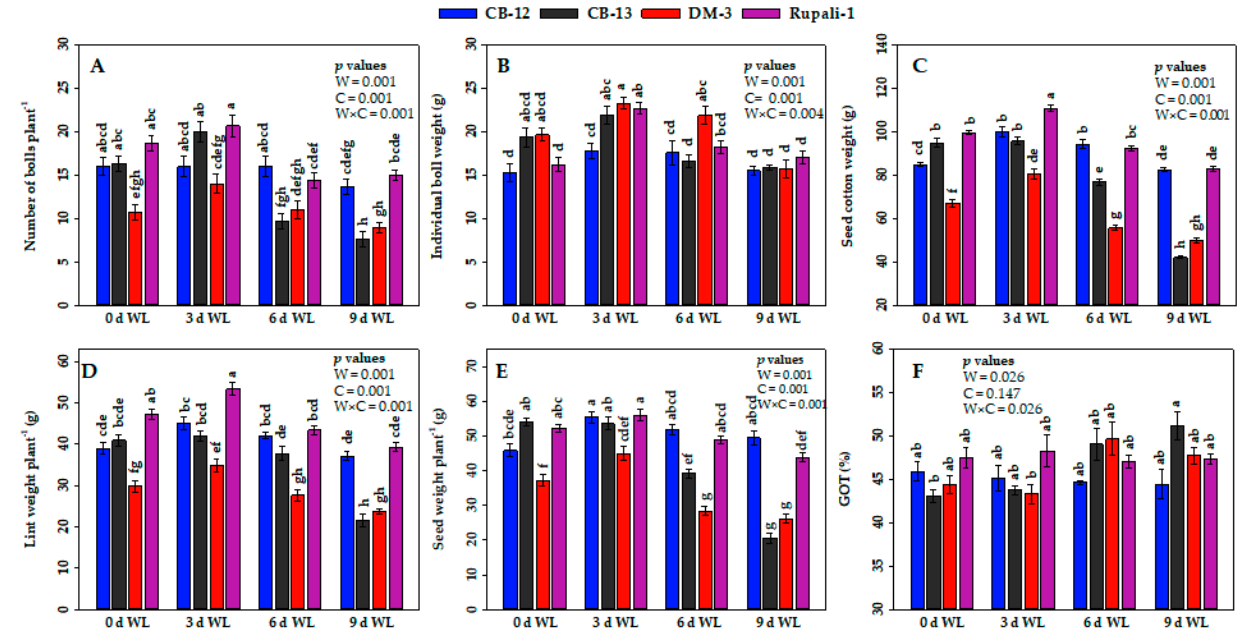
Figure 4. Effect of waterlogging (WL) on ( A ) number of bolls plant − 1 ; ( B ) individual boll weight; ( C ) seed cotton weight; ( D ) lint weight plant − 1 ; ( E ) seed weight plant − 1 ; and ( F ) ginning out turn (GOT). Values are means ± standard error. Bars connected with different letters have significant differences. p values are presented at the top right corner of the graphs. W = WL duration, C = cotton cultivar and W × C = interaction of WL duration and cotton cultivar, d; day(s).